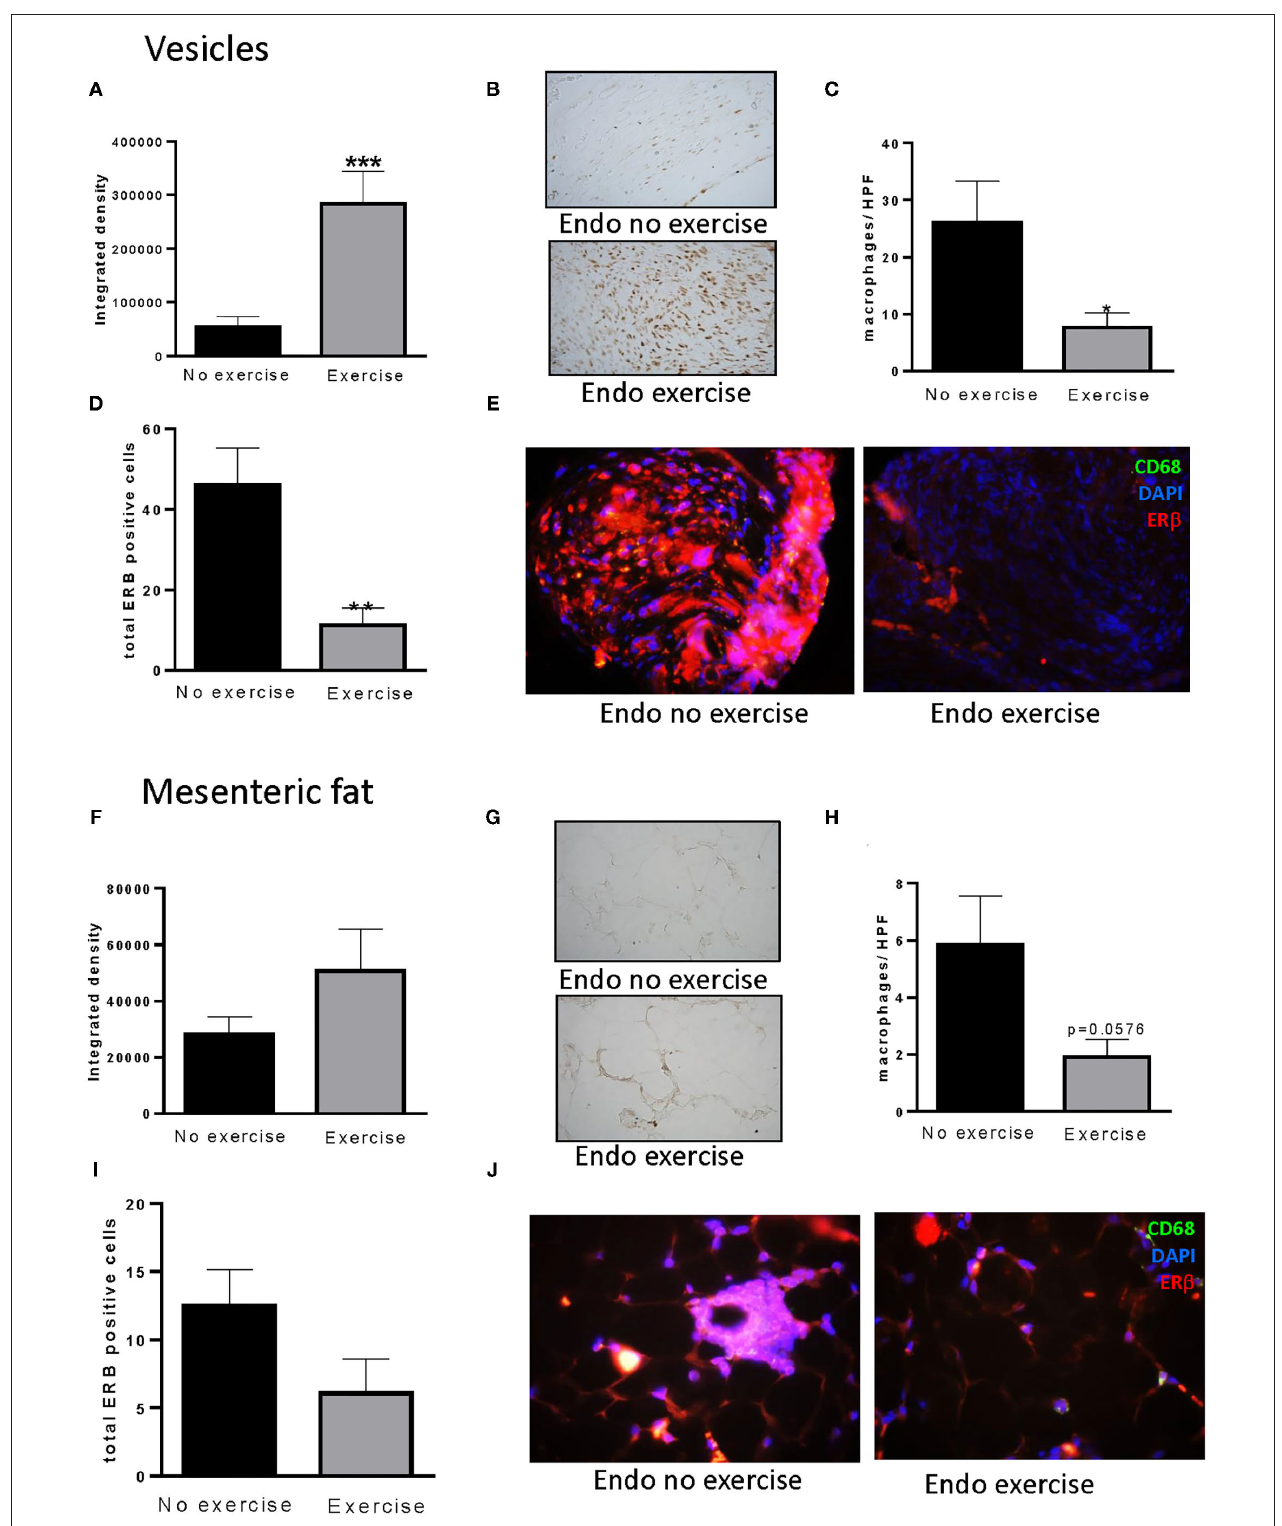
FIGURE 7 | Exercise impacts estrogen alpha receptors in vesicles and mesenteric fat. (A) Increased levels of ER α were found in vesicles of Endo-Exercise animals. (B) Representative photos of immunohistochemical staining for ER α in vesicles, x100. (C) Exercise decreased the total number of macrophages found per high power field and (D) the number of ER β positive cells in vesicles. (E) Representative photos of immunofluorescent staining of ER β and macrophages (CD68) in vesicles, x100.